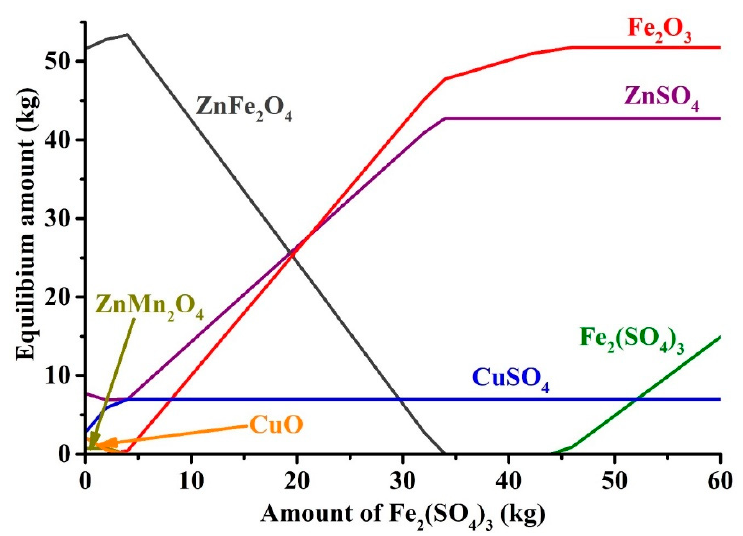
Figure 7. Effect of Fe 2 (SO 4 ) 3 addition to 100 kg of ZPR on the equilibrium amounts of Zn, Cu and Fe compounds at 625 °C.